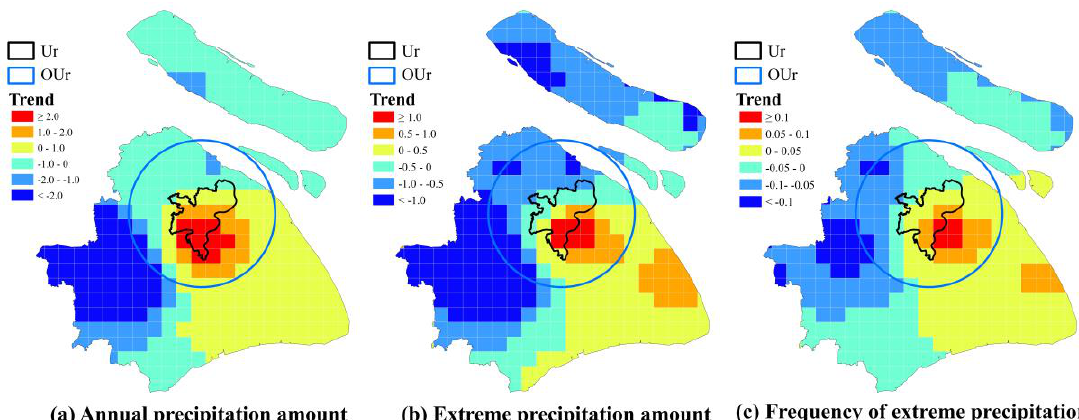
Figure 6. Spatial distribution of the trends for: ( a ) annual precipitation amount; ( b ) extreme precipitation amount; and ( c ) frequency of extreme precipitation.